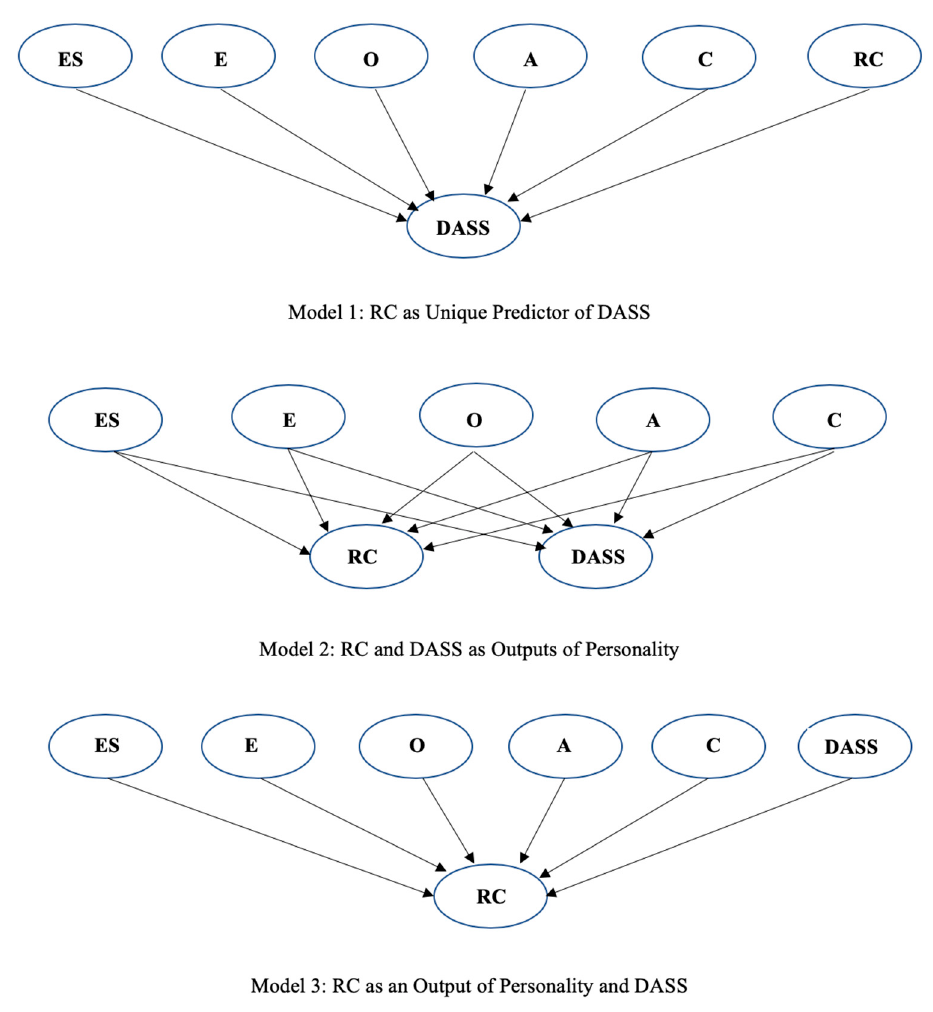
Figure 1. Proposed structural models linking religious crisis, personality, and psychological distress. Note: ES = emotional stability; E = extraversion; O = openness; A = agreeableness; C = conscientiousness; RC = religious crisis; and DASS = Depression, Anxiety, and Stress Scale-21.